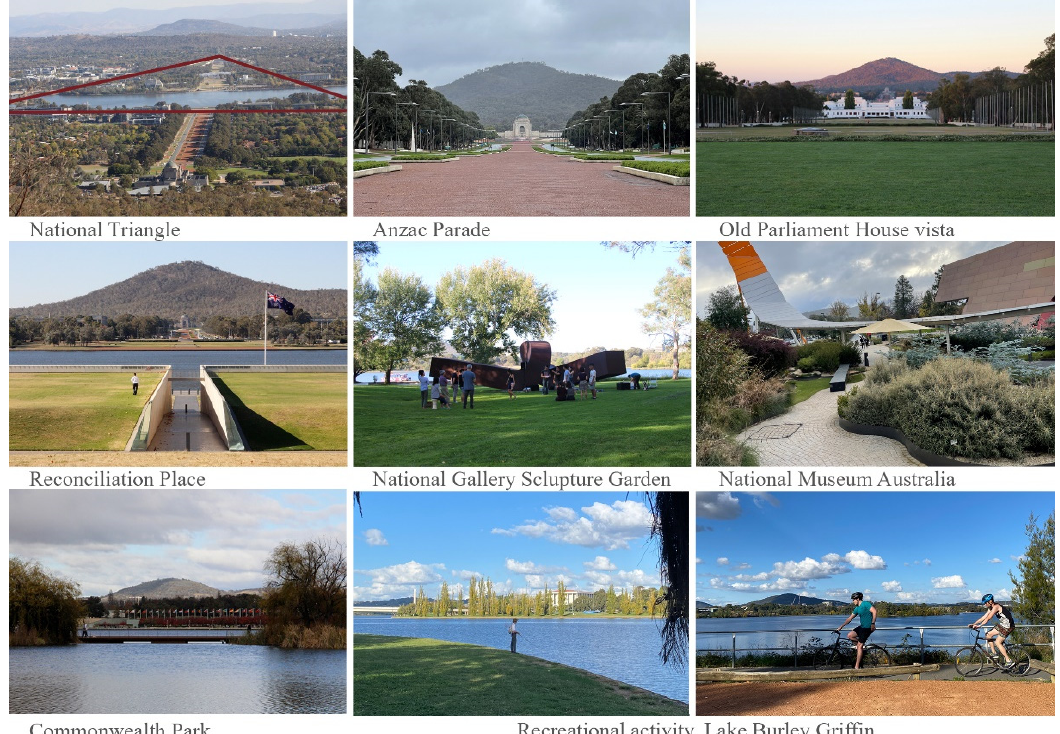
Figure 5. The photos show some of the valuable green spaces from the socio-cultural ESS perspective. Photos: Authors.